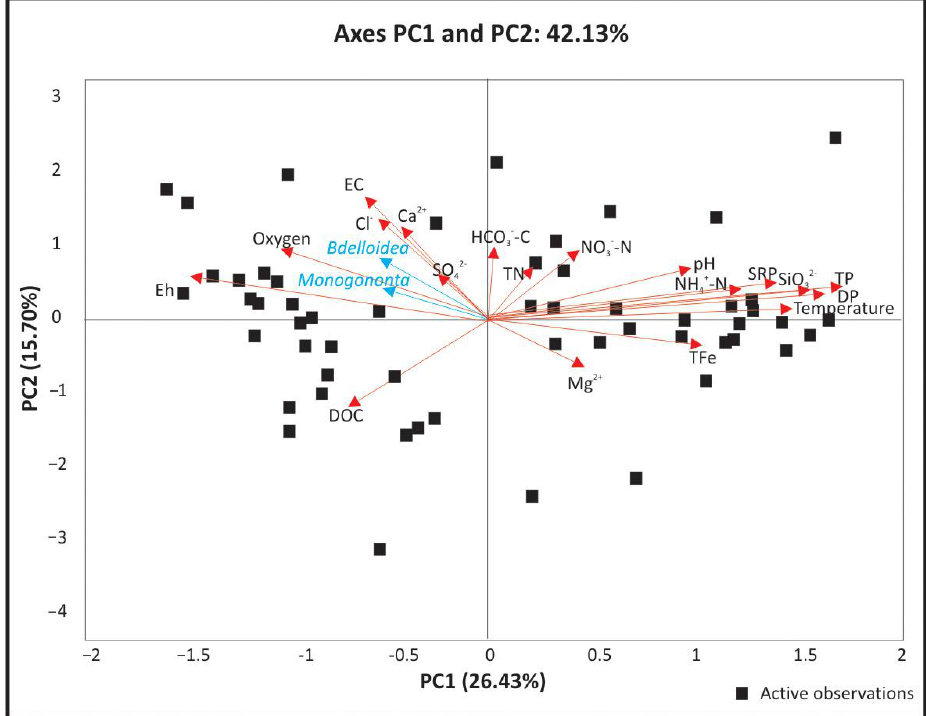
Figure 6. Principal component analysis (PCA) biplot; factor loadings of water quality parameters and Monogononta and Bdelloidea numbers are shown as arrows and water sample sites as points (N = 56).